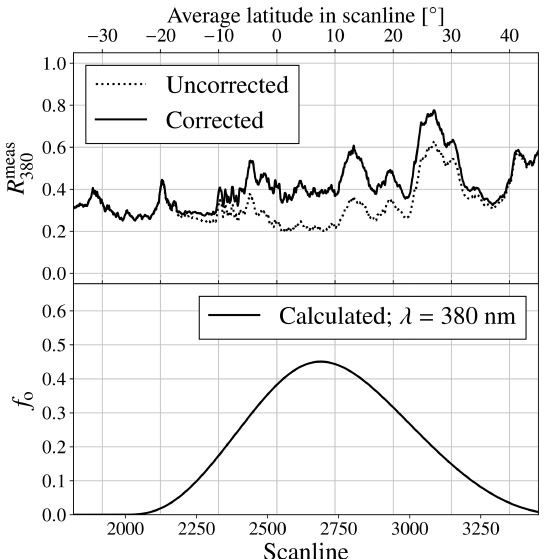
Figure 12. The average solar irradiance corrected (solid line) and uncorrected (dotted line) measured top-of-atmosphere reflectance at 380nm by TROPOMI at 26 December 2019 in orbit 11404 per scan line (top image), and the corresponding average calculated ob- scuration fraction f o at 380nm (bottom